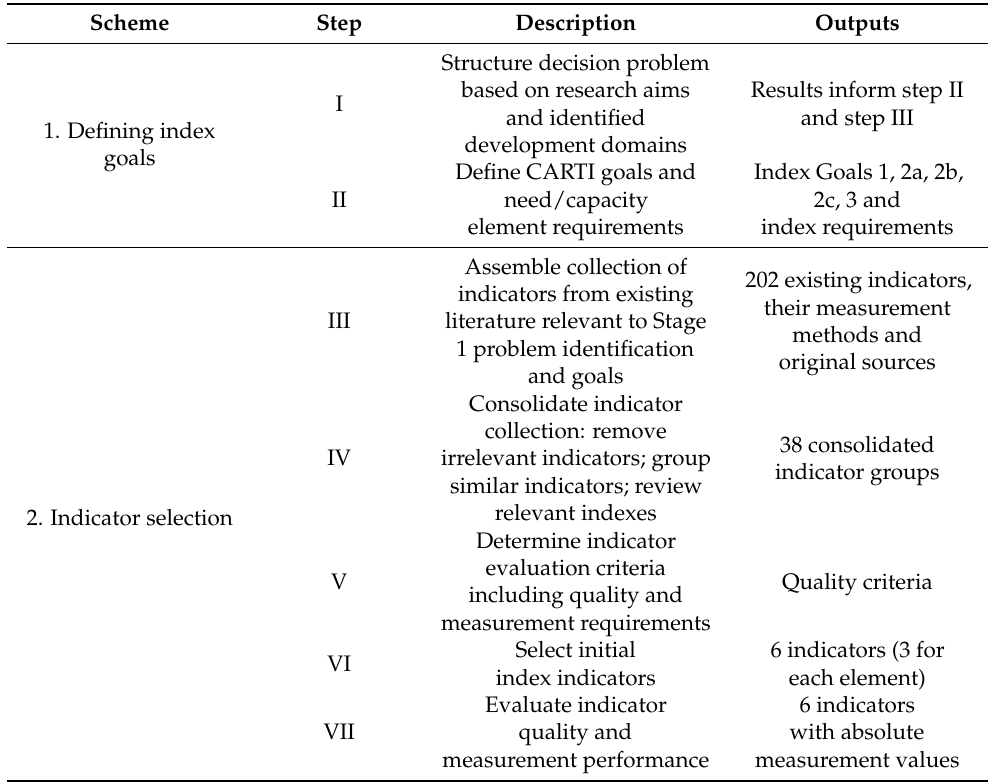
Table 1. CARTI development